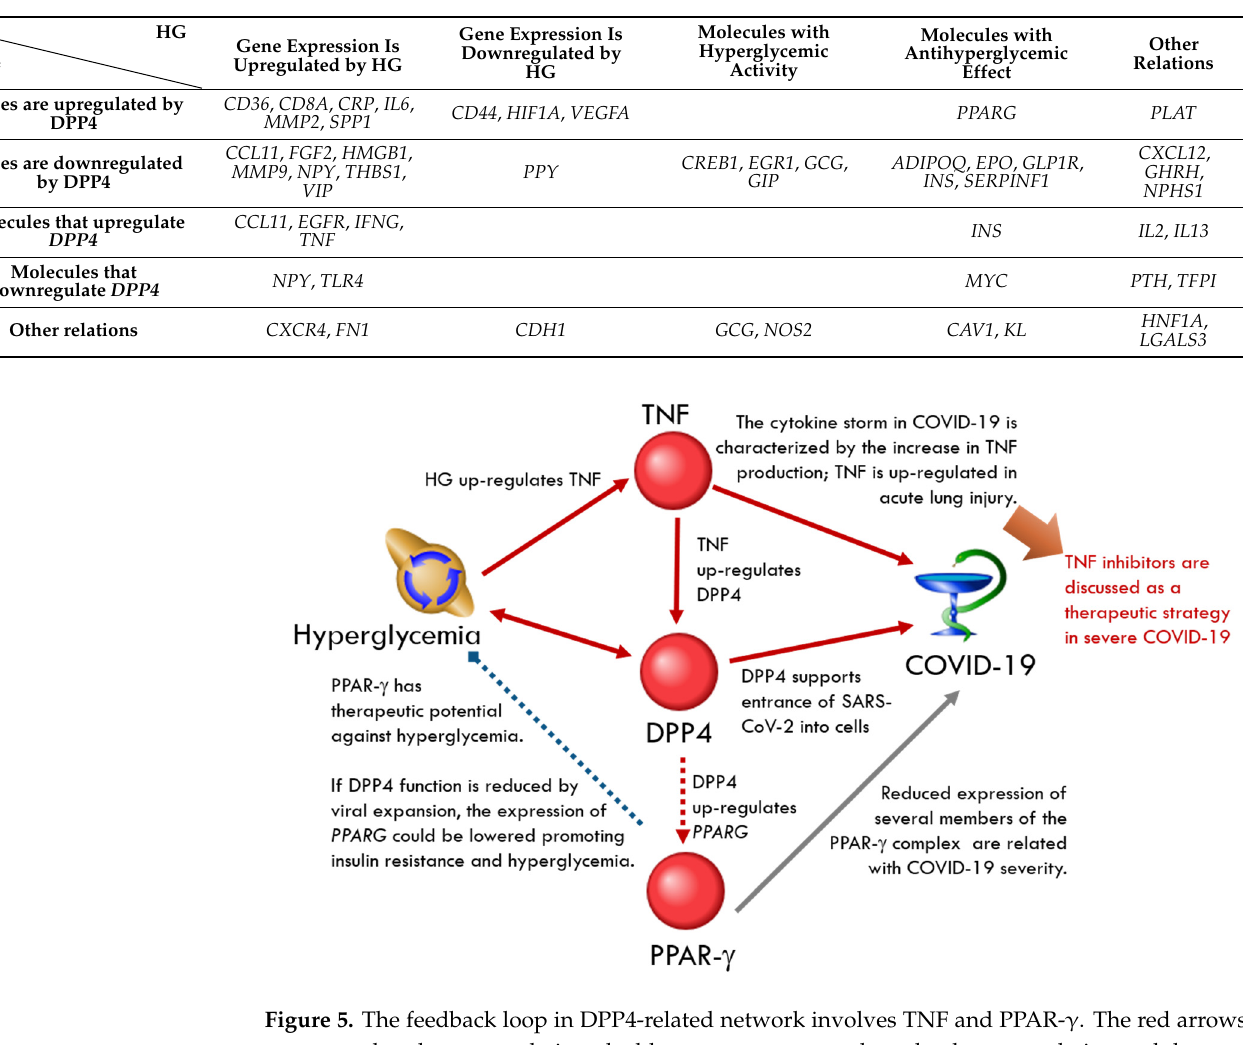
Table 5. Most overrepresented GO biological processes that are common for the sets of genes linked with DPP4 and are associated with hyperglycemia, CVD, diabetic neuropathy, diabetic nephropa- thy, diabetic retinopathy, insulin resistance, and beta-cell dysfunction.